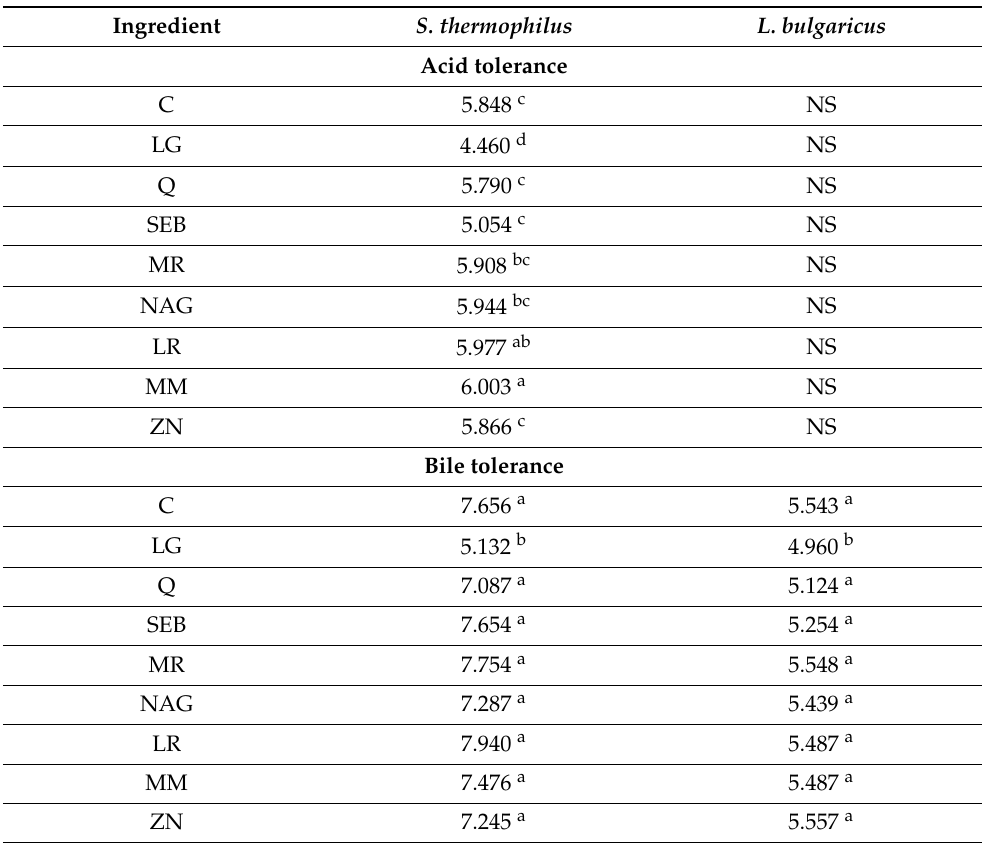
Table 2. Least squares means for acid and bile tolerance of L. bulgaricus and S. thermophilus as influenced by